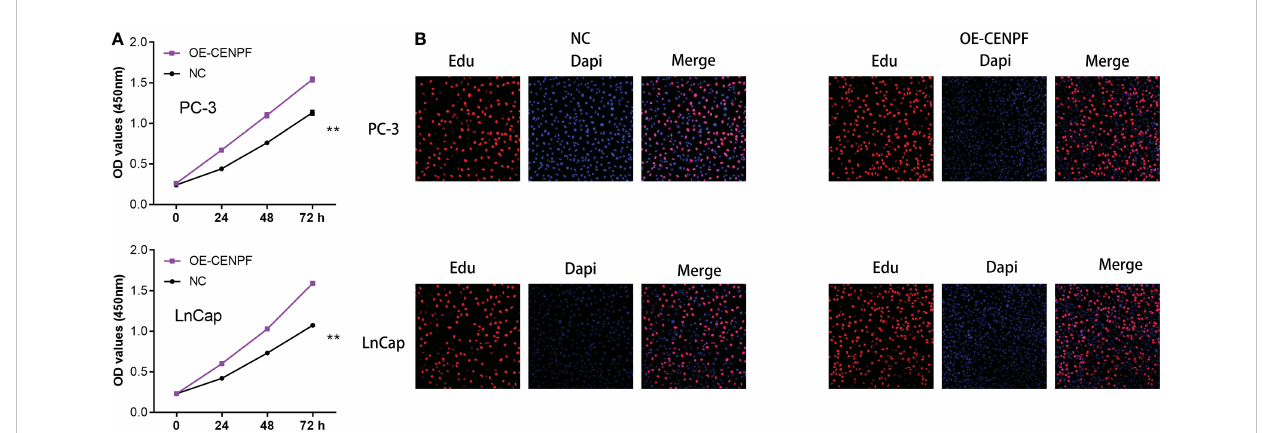
FIGURE 8 (A) The CCK8 assay demonstrated the proliferation ability in prostate cancer cells; (B) The Edu assay demonstrated the proliferation ability in prostate cancer cells. **: